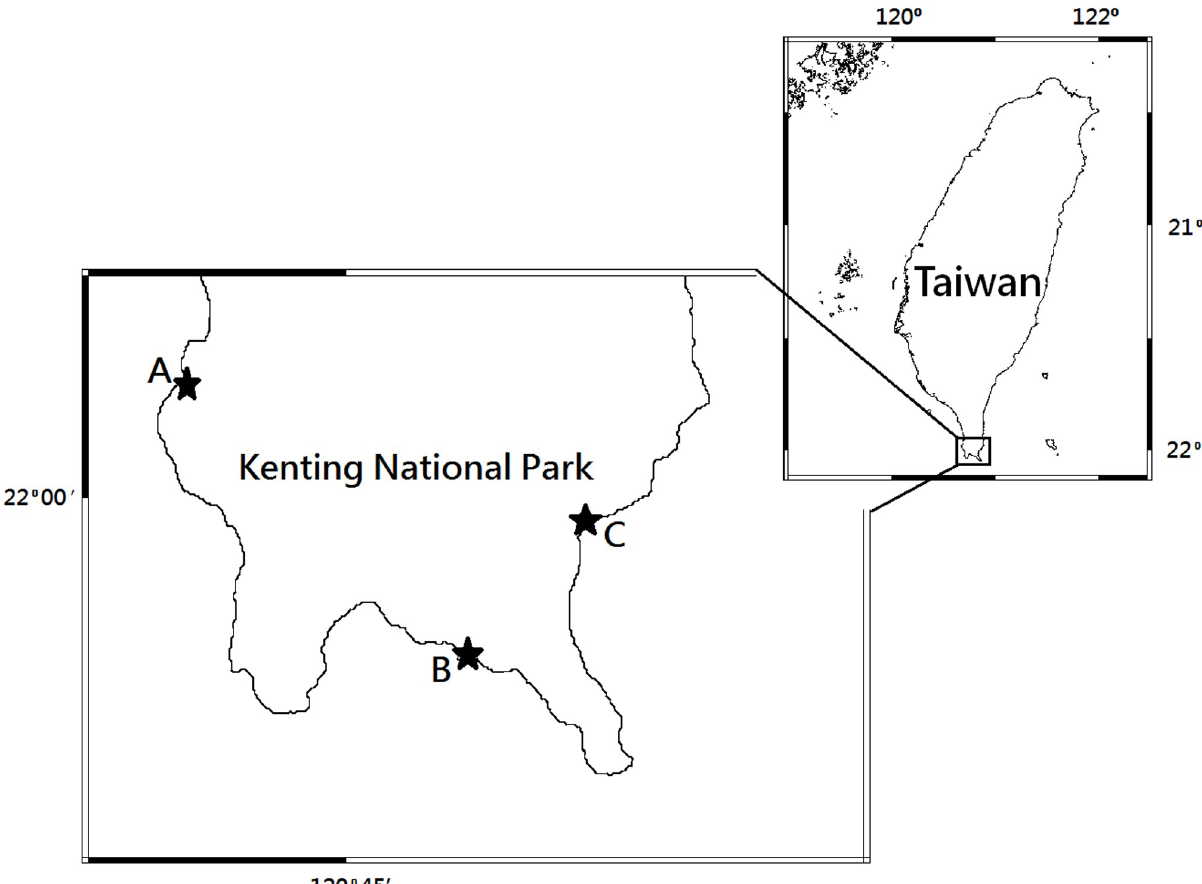
Fig 1. Sampling sites in this study. (A) Houwan; (B) Qingwashi; (C) Gangkou.